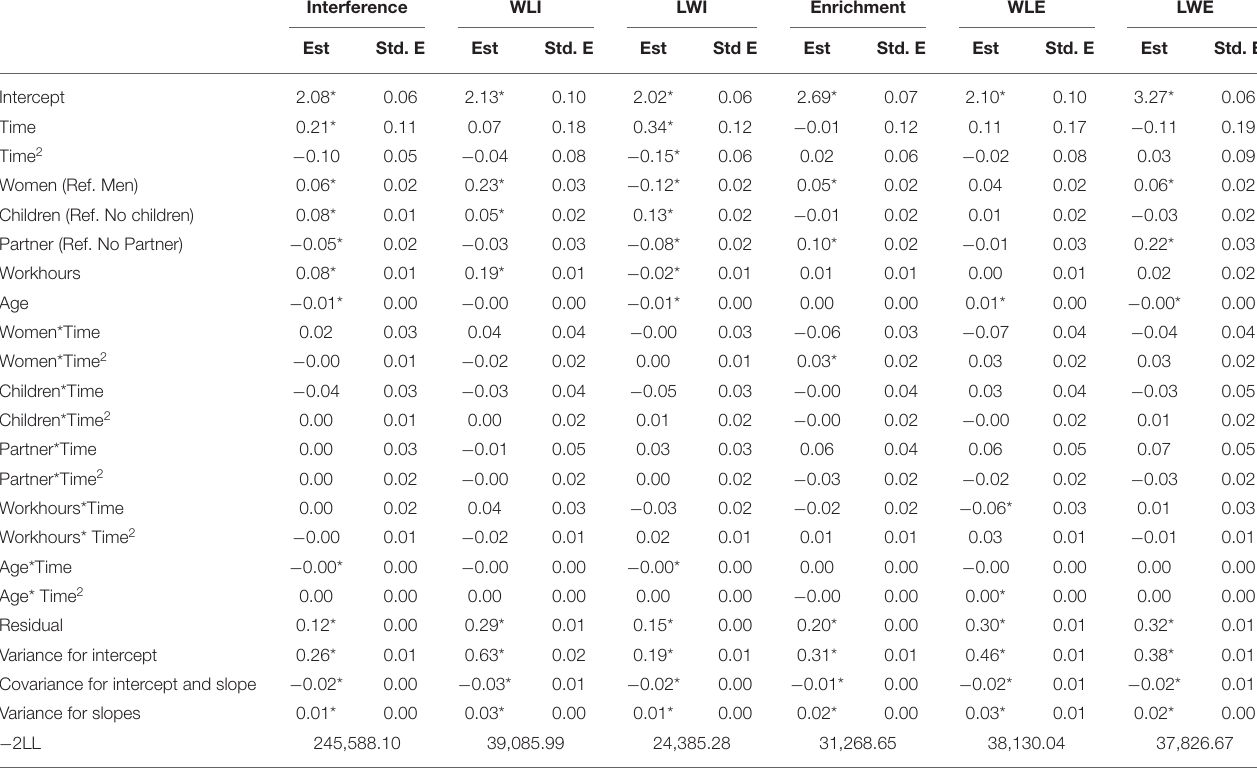
TABLE 3 | Quadratic growth curve for interference, WLI, LWI, enrichment, WLE, and LWE, respectively, including covariance variables (gender, having children, having partner, work hours, and age). Interference WLI LWI Enrichment WLE LWE Est Std. E Est Std. E